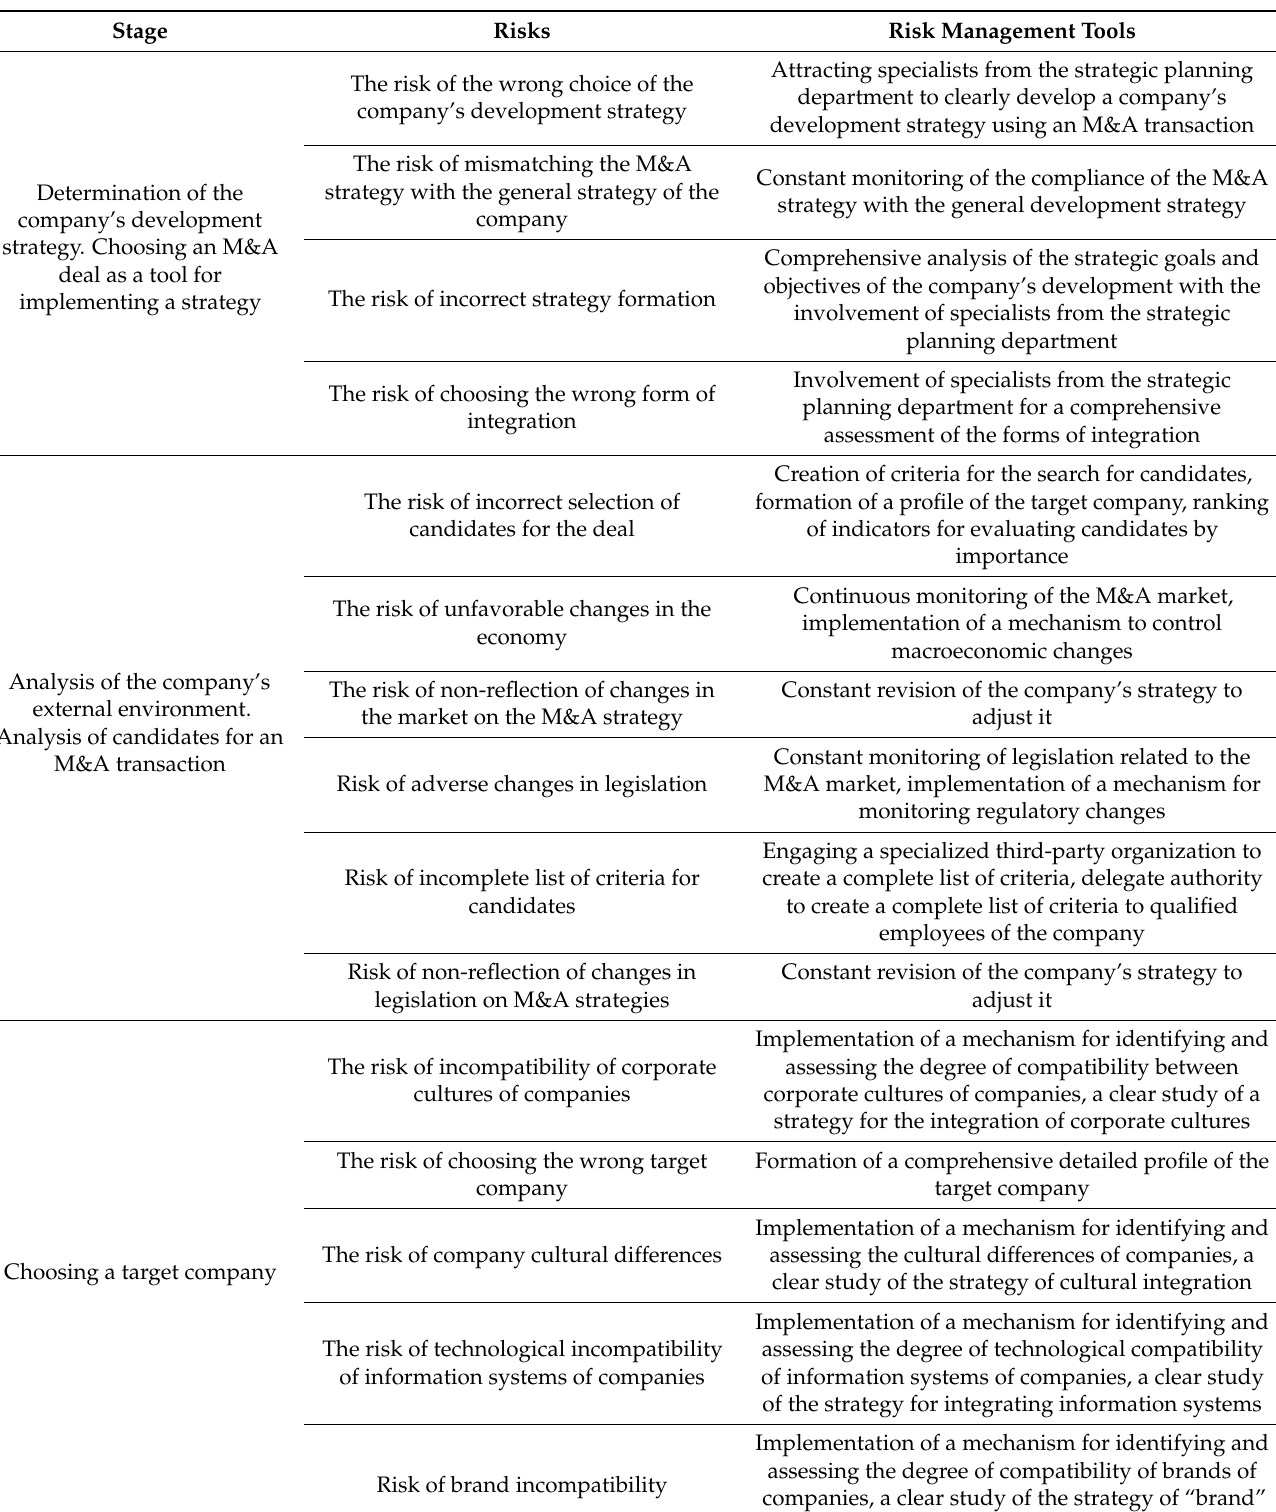
Table A2. Relevant tools for risk management of mergers and acquisitions at each stage of the transaction.